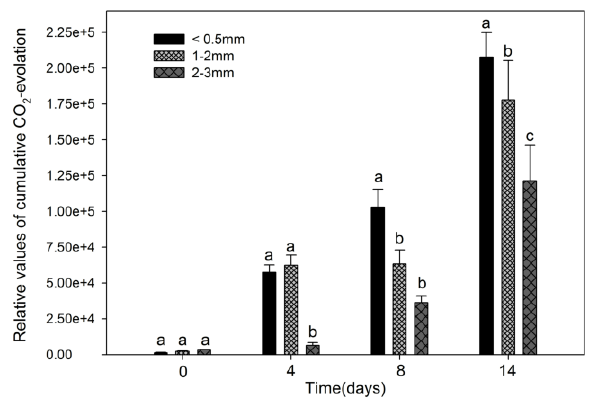
-evolation of different size aggregates 2